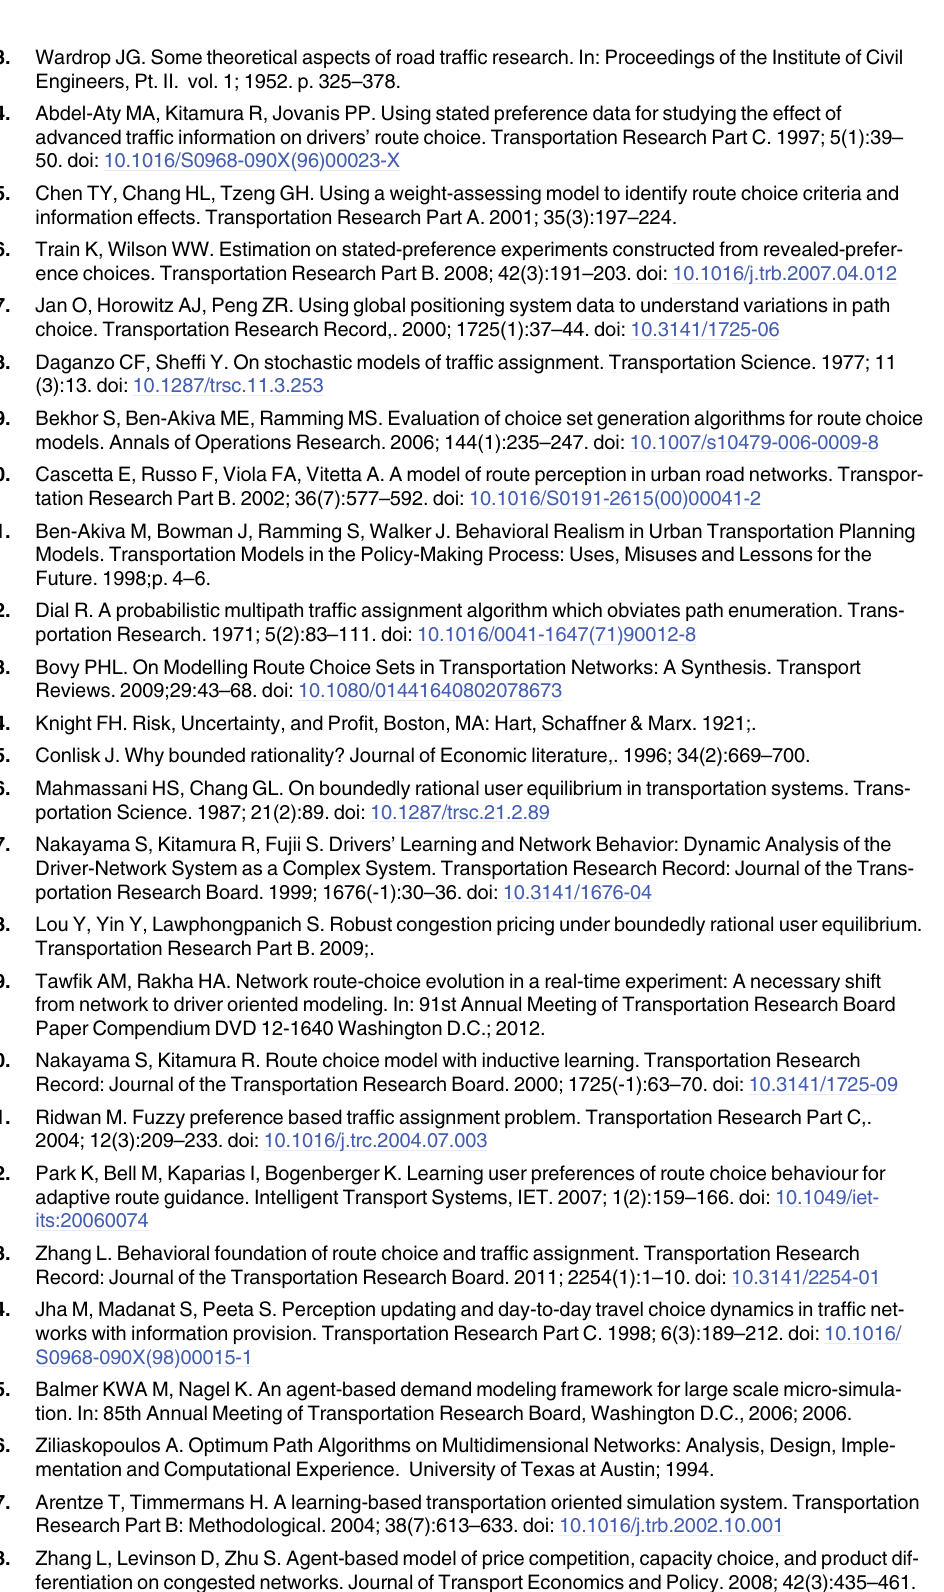
PLOS ONE | DOI:10.1371/journal.pone.0134322 August 12,